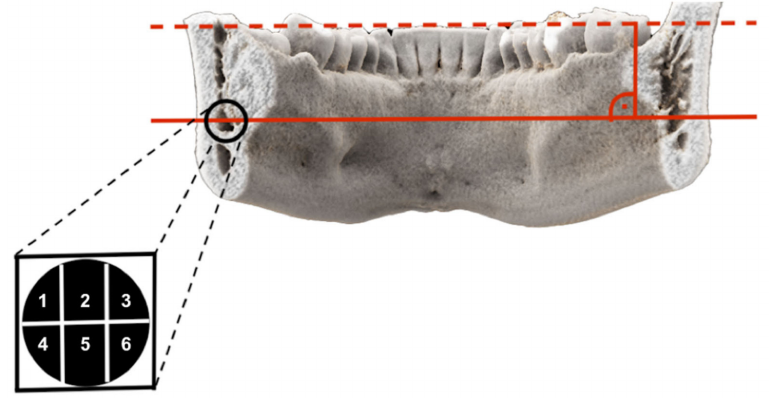
Figure 1. Photorealistic three-dimensional (3D) visualization of a study participant’s